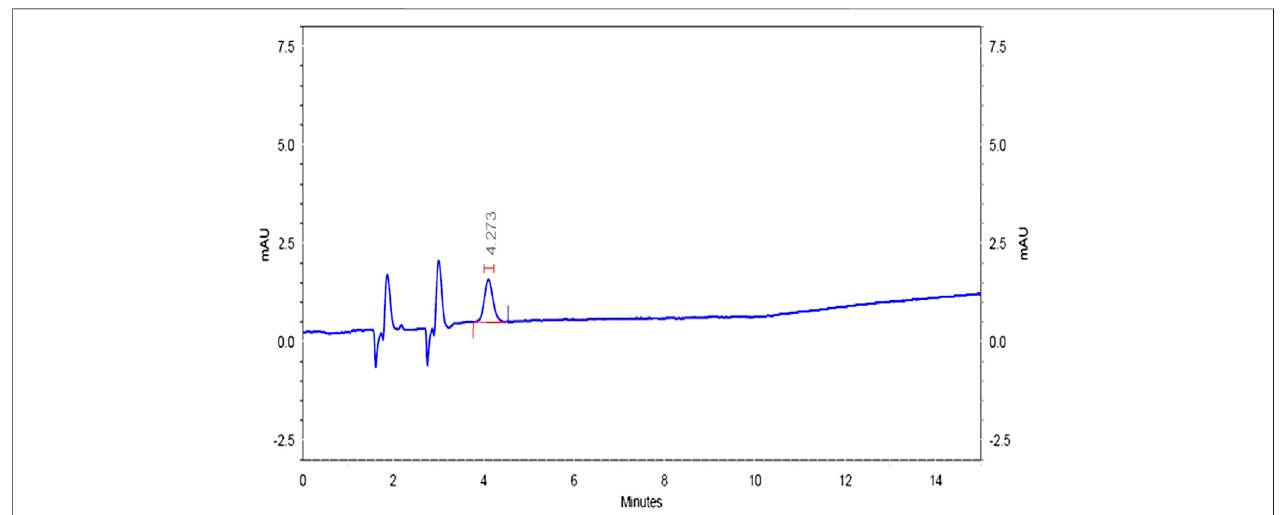
FIGURE 8 | Representative chromatogram of the fl umioxazin test item in Milli-Q water.